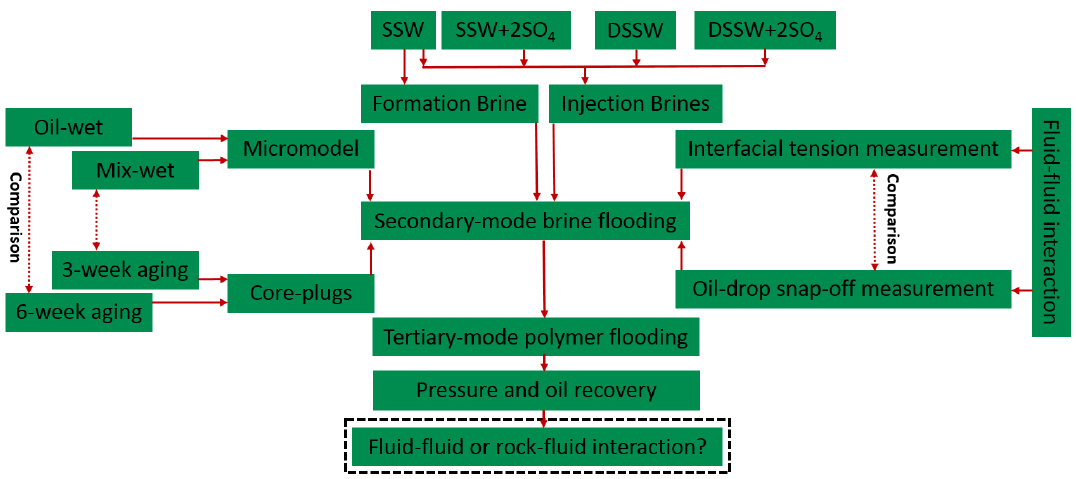
Figure 1. Adopted workflow considered during this study to establish the conclusive study .